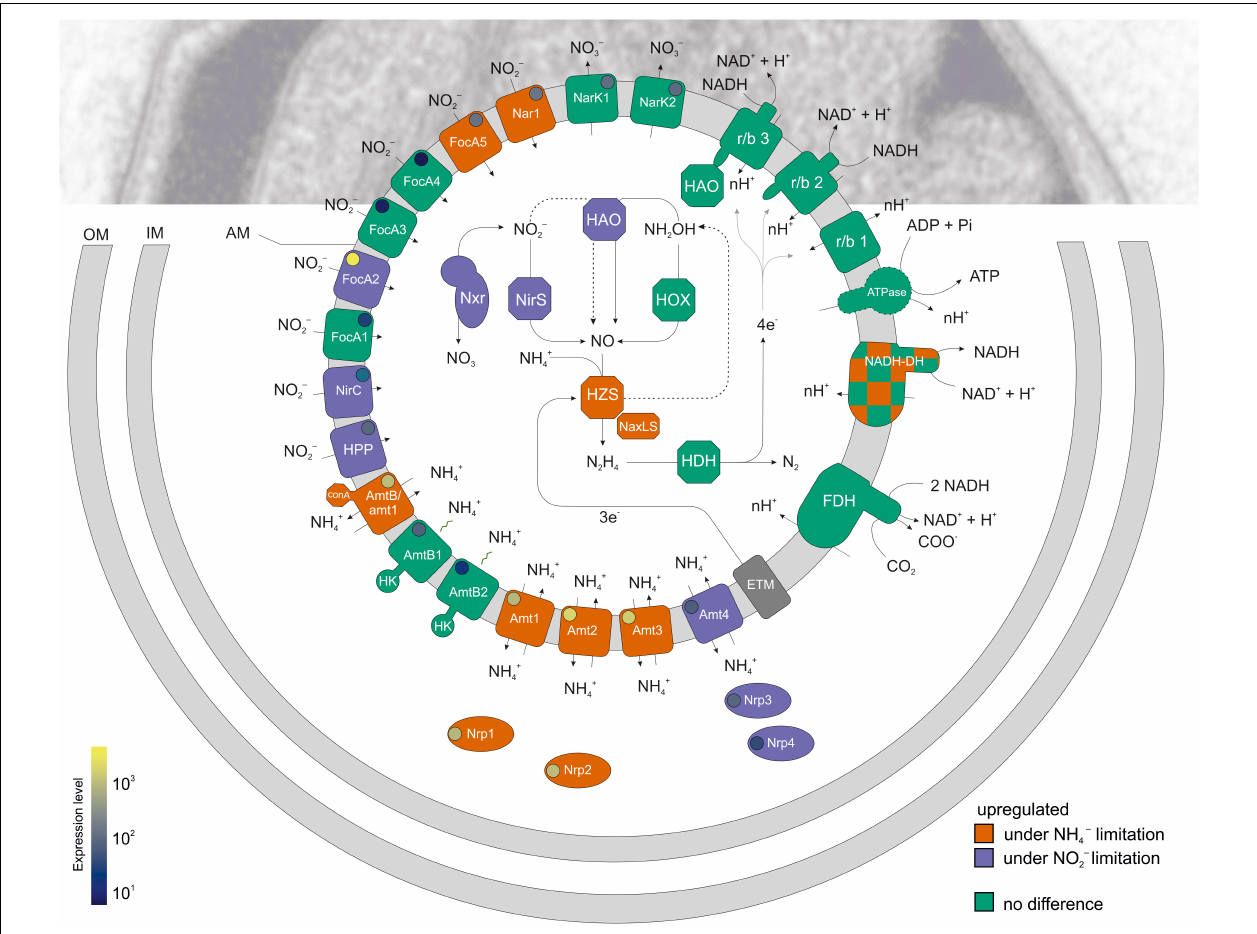
FIGURE 3 | A schematic overview of a K. stuttgartiensis cell and the differential expression of gene products related to metabolism and nutrient transport under nitrite- versus ammonium limited bioreactor growth conditions. Transporters have been drawn on the anammoxosome membrane for comparison but their localization on either of the three anammox membranes awaits experimental validation. Genes up-regulated under nitrite- relative to ammonium limiting conditions are indicated in purple and genes upregulated under ammonium- relative to nitrite-limiting conditions are indicated in orange. Genes that are not affected when grown under either nitrite- or ammonium-limiting conditions are indicated in green. A circle within each transport related gene indicates relative expression level. OM, outer membrane; IM, inner (cytoplasmic) membrane; AM, anammoxosome membrane; HK, histidine kinase domain. Proteins depicted in this image: